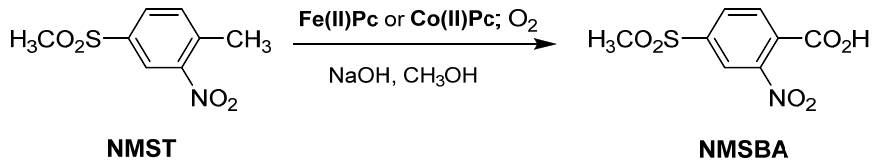
Figure 29. Cobalt(II) and iron(II) phthalocyanines used for the catalytic oxidation of 2-nitro-4-methylsulfonyltoluene (NMST) into the 2-nitro-4-methylsulfonylbenzoic acid (NMSBA) (adapted from